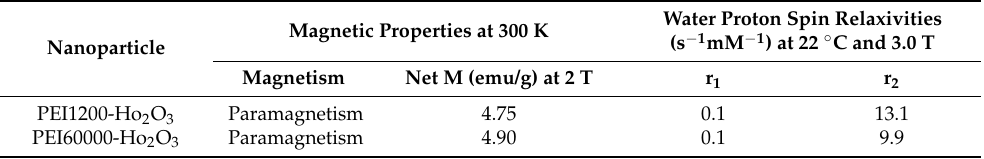
Table 3. Magnetic properties and water proton spin relaxivities.